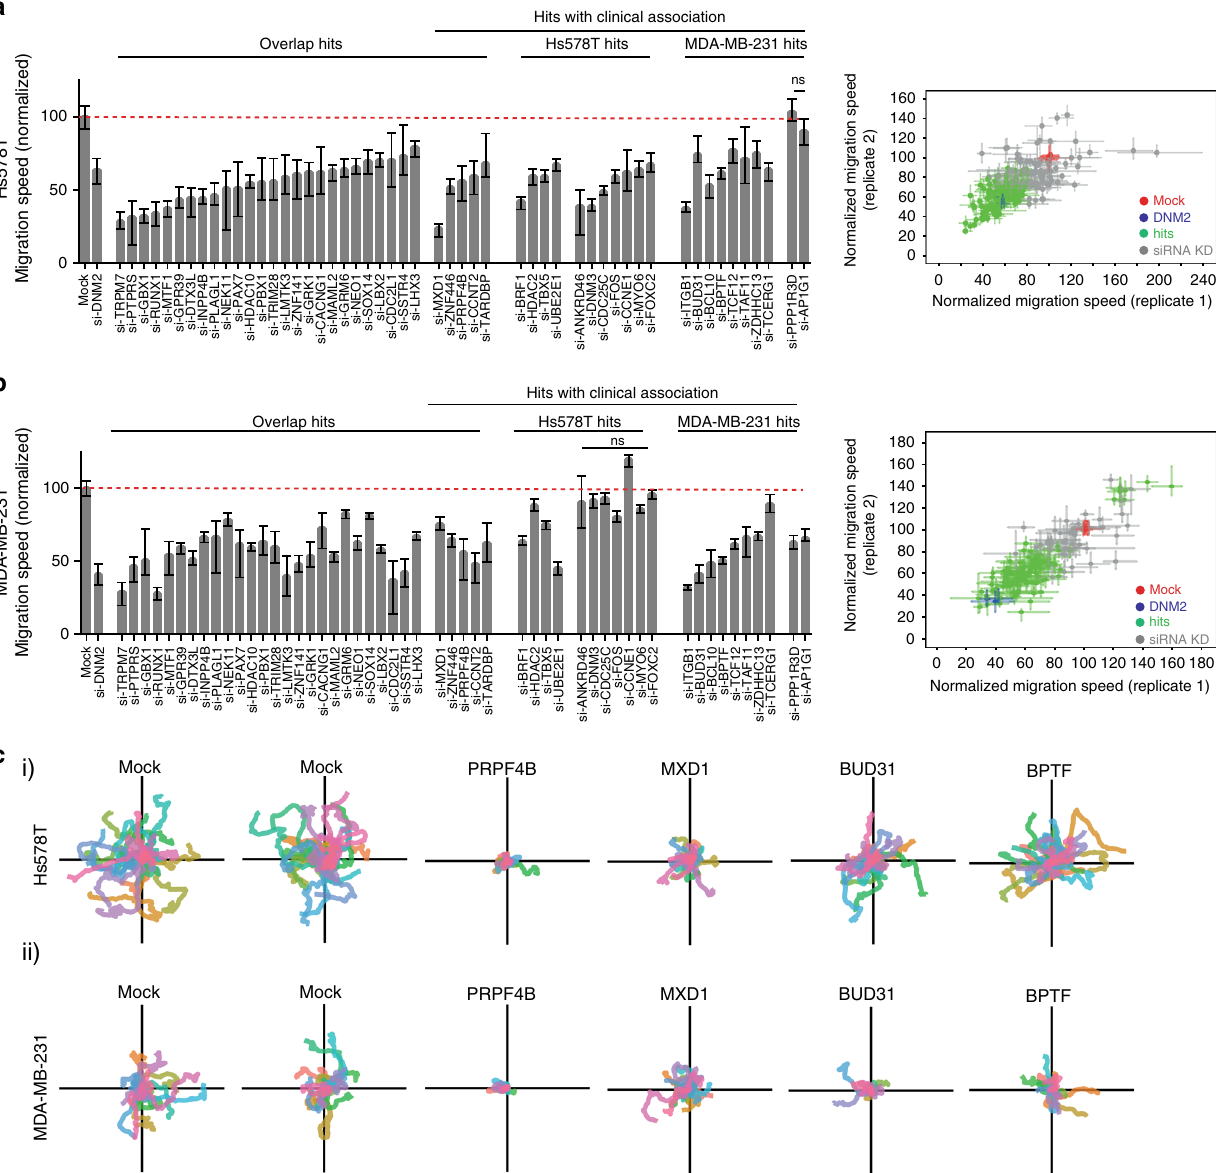
Fig. 3 Candidate genes directly affect TNBC cell migratory behavior. a Quanti fi cation of single cell migration speed of Hs578T-GFP cells after knockdown of validated hits. Hs578T-GFP cells were transfected with siRNAs and cell migration was assessed by live microscopy. Hits that showed signi fi cant and consistent effects in both replicates were considered as candidate genes (right panel). Median ± 95% con fi dence interval is shown and cell populations were compared by Kruskal – Wallis test with Dunn ’ s post correction test. b Same as in a , with MDA-MB-231-GFP cells. c Single cell trajectories of cell migration upon knockdown of PRPF4B , MXD1 , BUD31 , or BPTF in (i) Hs578T and (ii) MDA-MB-231 cell